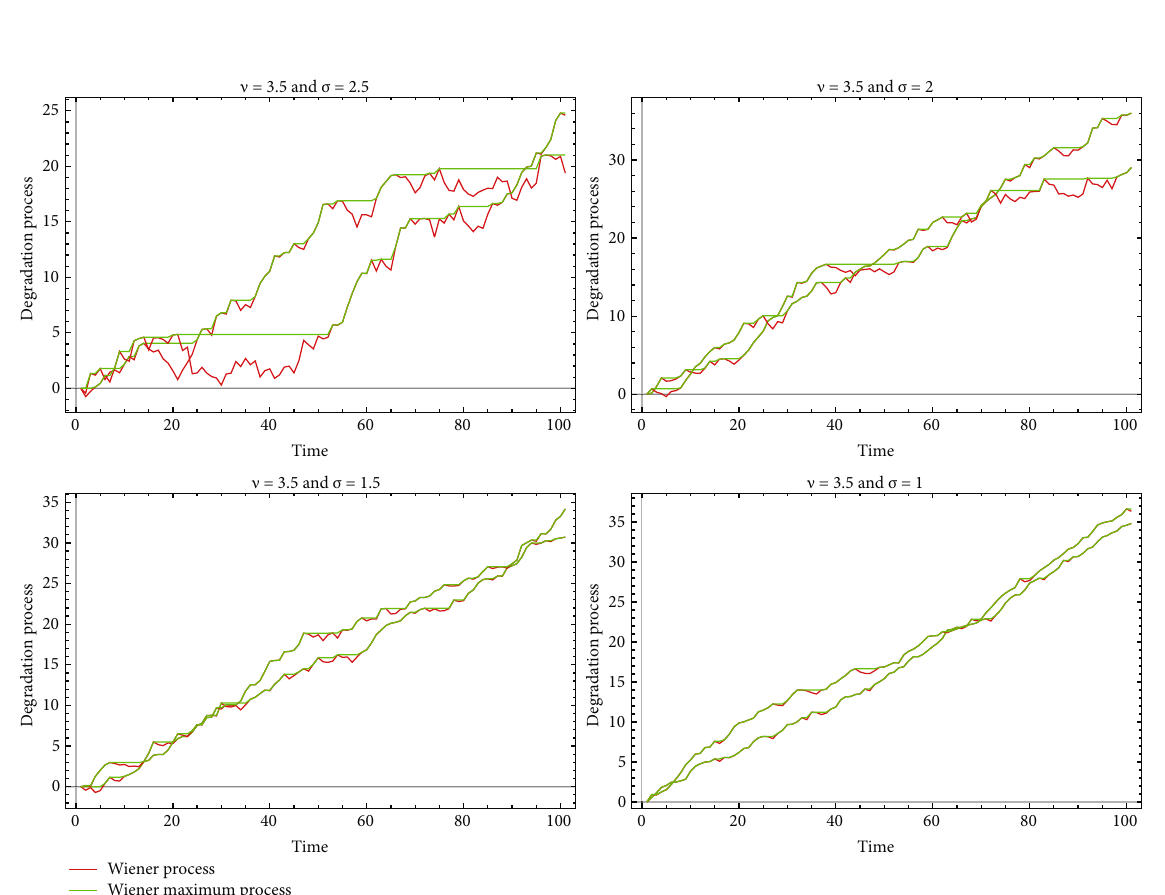
Figure 8: Simulated sample paths for the Wiener processes with drift (red) and Wiener maximum processes